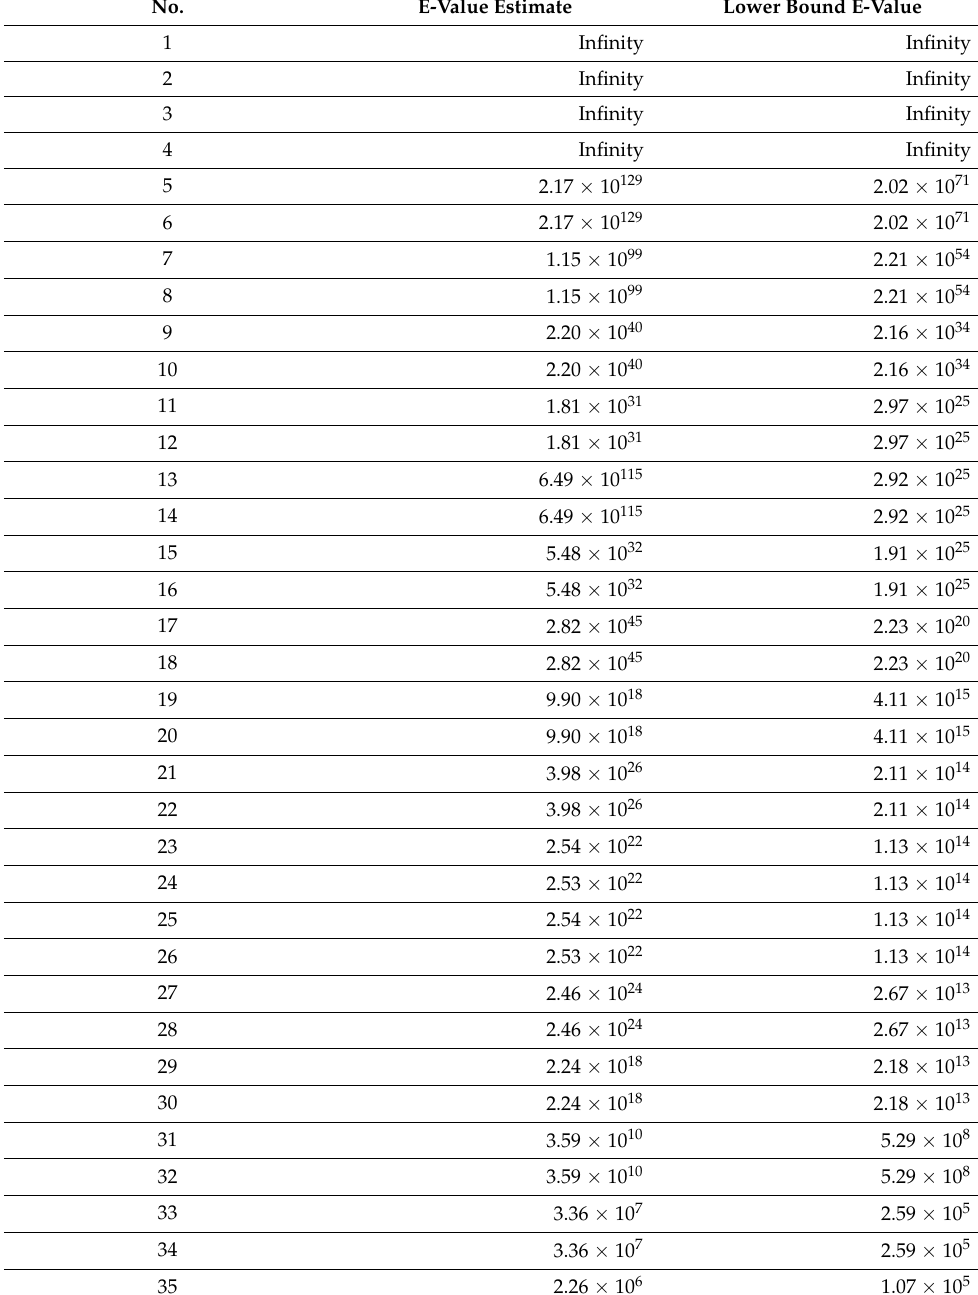
Table 7. List of All